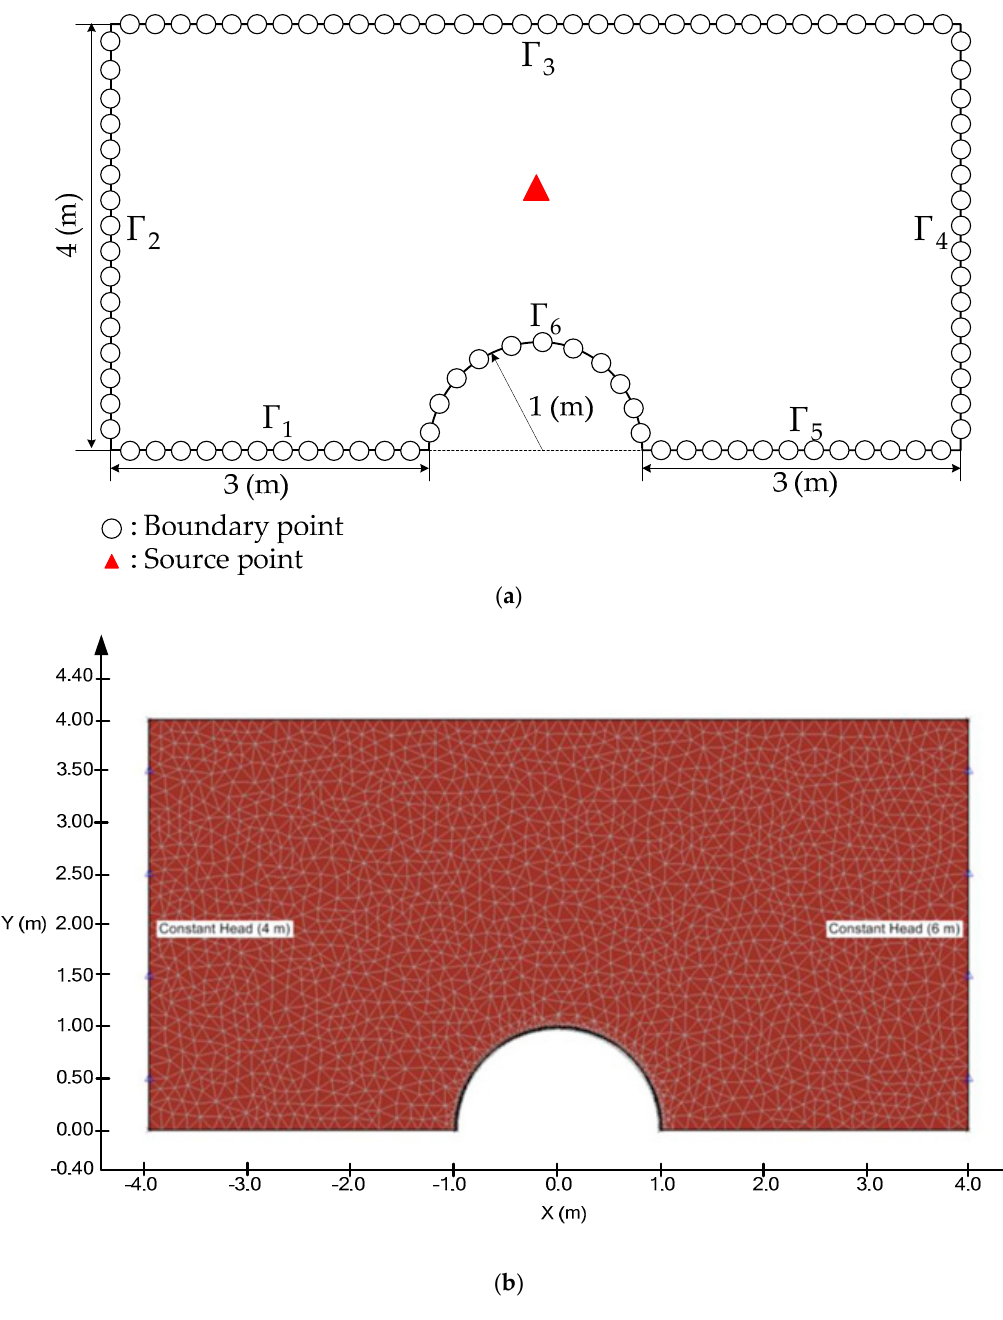
Figure 4. Comparison of the domain discretization. ( a ) The CTM and ( b ) the finite element method. The Dirichlet and Neumann data are applied on the domain boundary, Γ , including Γ 1 , Γ 2 , . . . , Γ 6